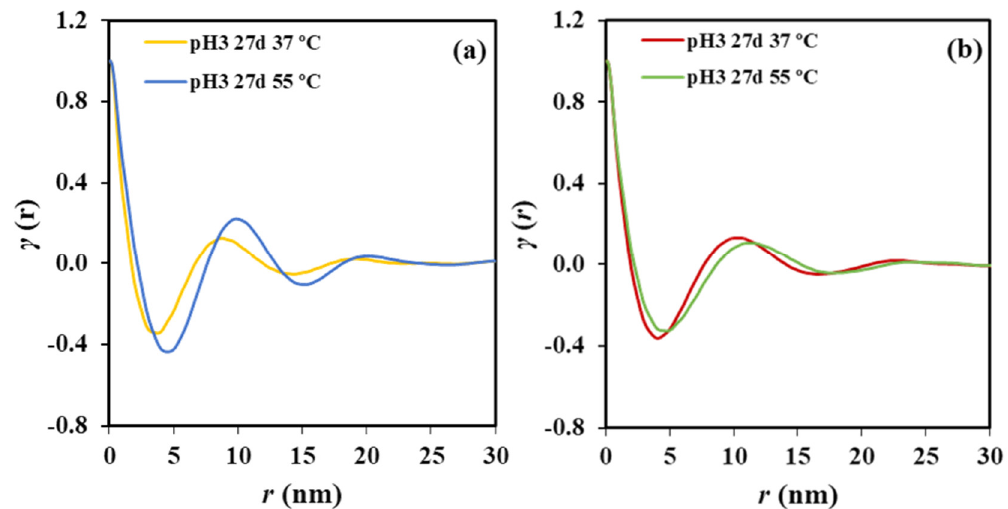
Figure 6. ( a ) Correlation function of the SAXS peak determined for the P4HB film exposed to a pH 3 medium at 37 and 55 °C for 27 days. ( b ) Correlation function of the SAXS peak determined for the P4HB suture exposed to a pH 3 medium at 37 and 55 °C for 27 days.